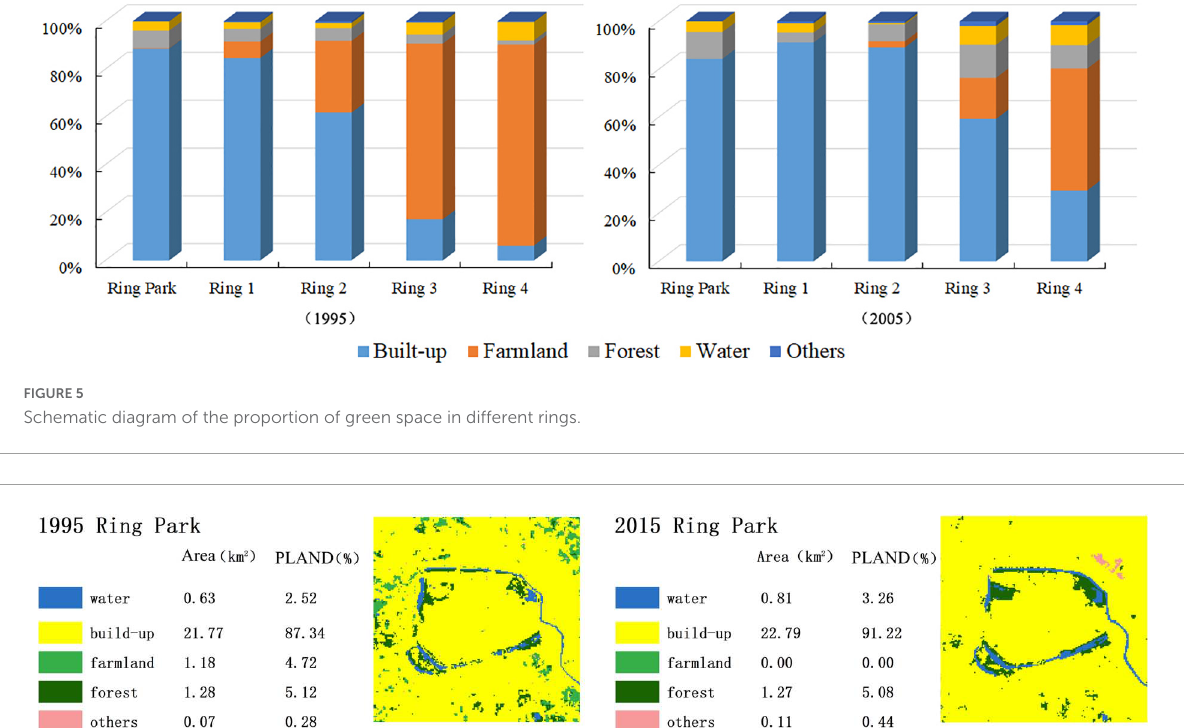
FIGURE6 Distribution of green space in three regions in 1995 and 2015.